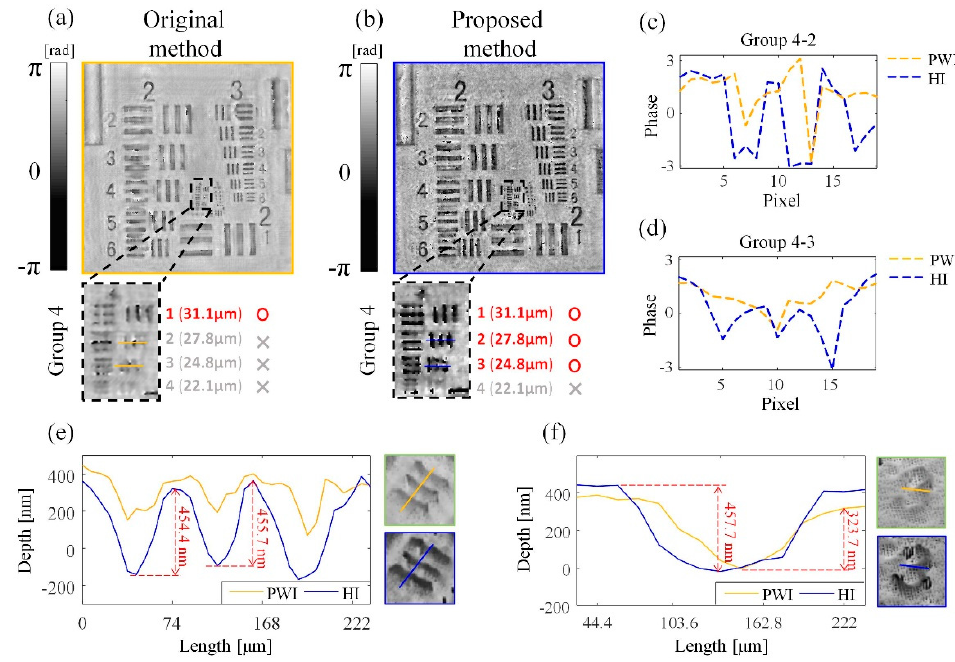
Figure 10. The reconstruction results of a quantified phase resolution plate. ( a , b ) are the reconstructed images using the original method and proposed method, respectively. ( c , d ) is the cross-section phase distribution of groups 4-2 and 4-3, respectively. ( e , f ) is the depth values of the retrieved lines in groups 3-5 and 3-3, respectively.